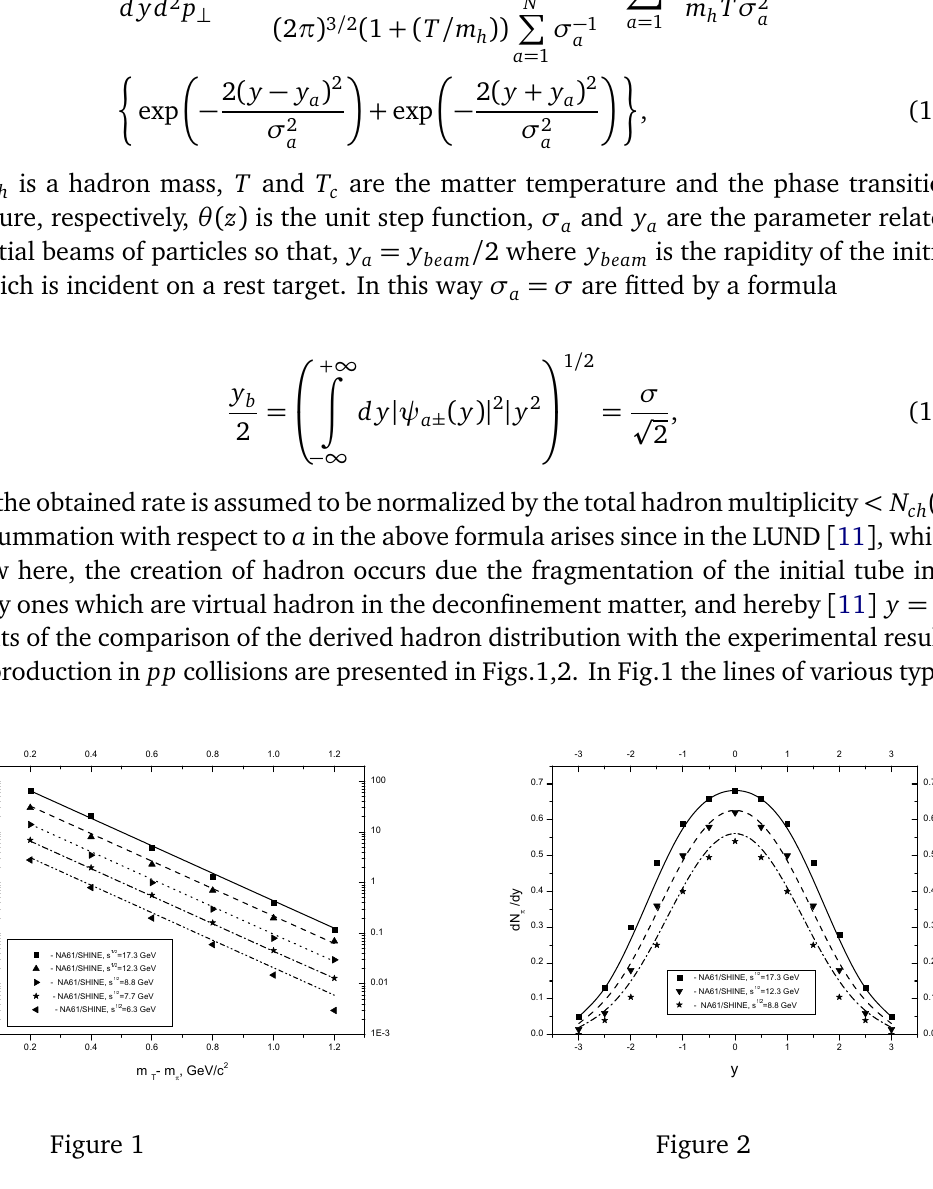
= 160 MeV , and are c − m ) = 0.2 GeV / c , v.s. the π T (cid:112) (cid:112) s = 12,3 GeV (dashed line), s = 8,8 GeV